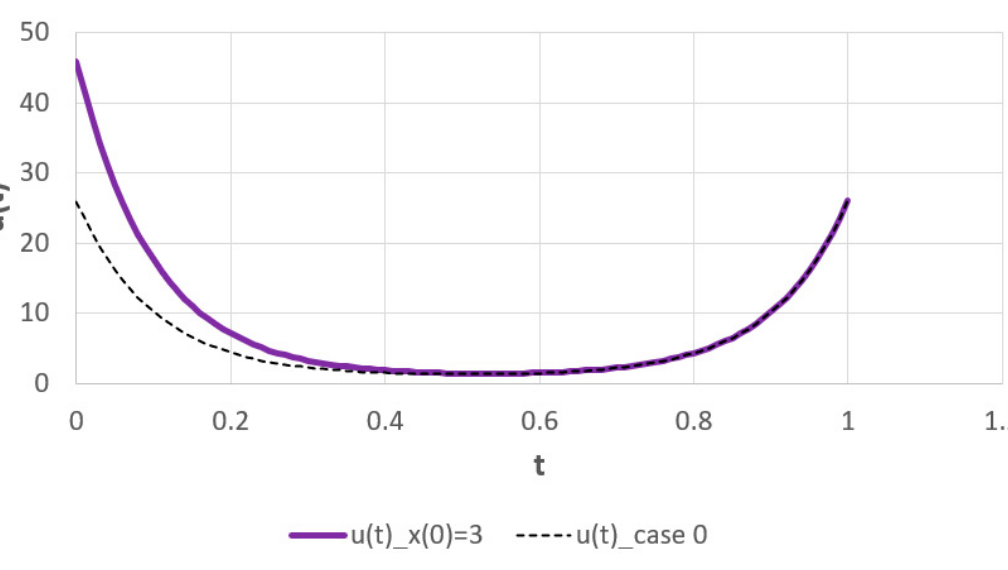
Figure 12. The optimal time path of x in Dynamic case 1.